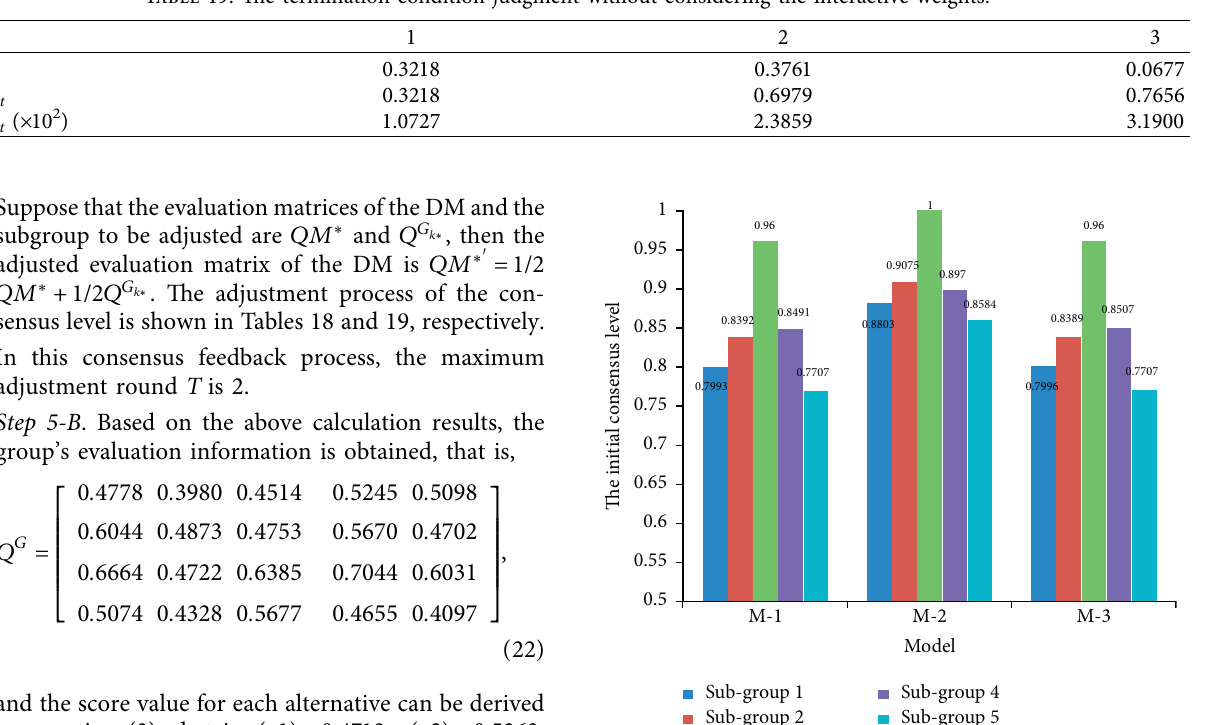
Table 19: .e termination condition judgment without considering the interactive weights.